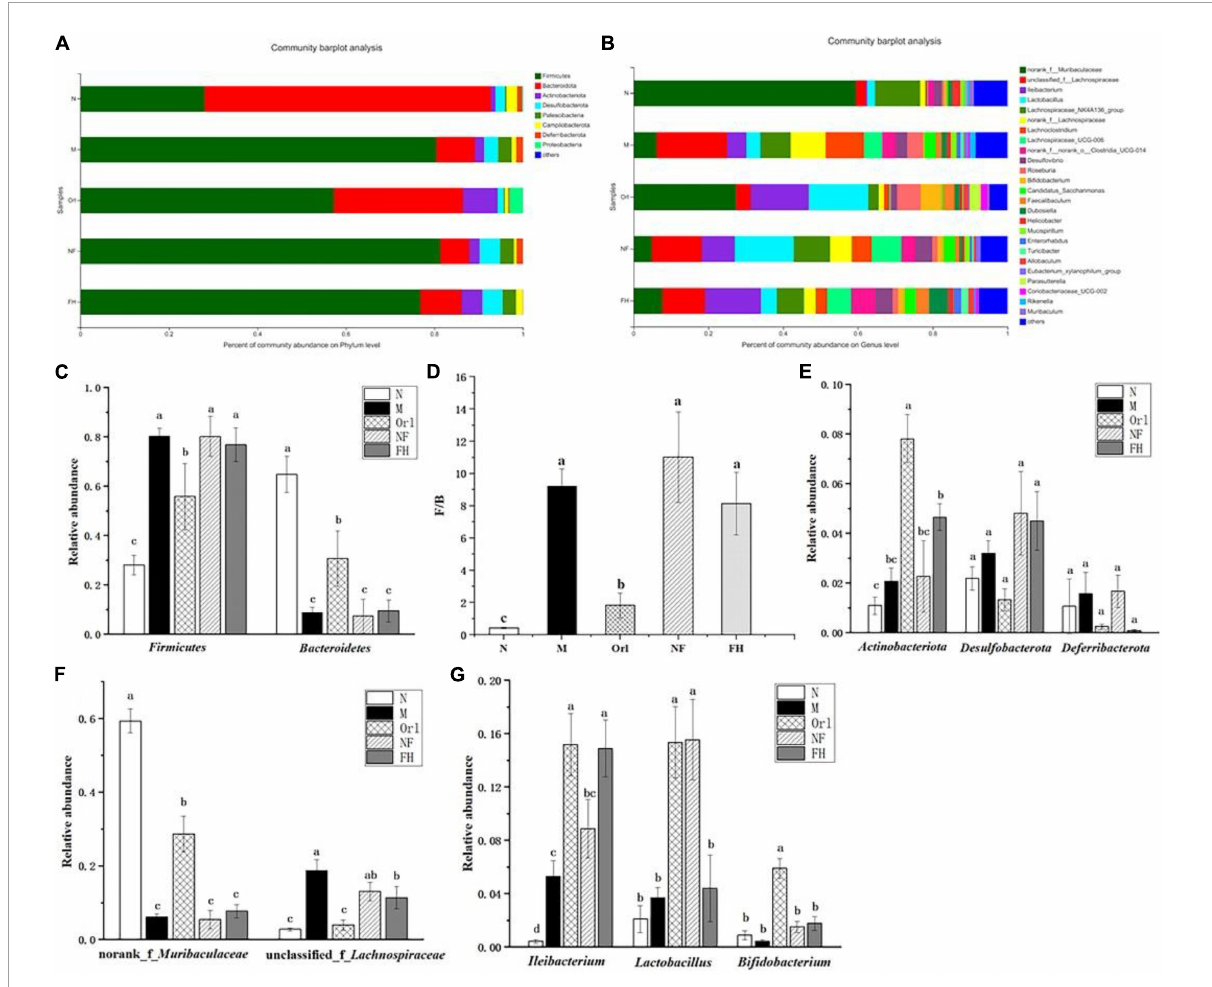
FIGURE6 Effects of FAK on gut microbes in mice. (A) Relative abundance at the gut microbial phylum level. (B) Relative abundance at the gut microbial genus level. (C–E) Relative abundance of gut microbiota at the phylum level. (F,G) Relative abundance of gut microbiota at the genus level. All data are expressed as mean ± SD ( n = 5). (a–c) Bands with different letters indicate significant differences ( P <